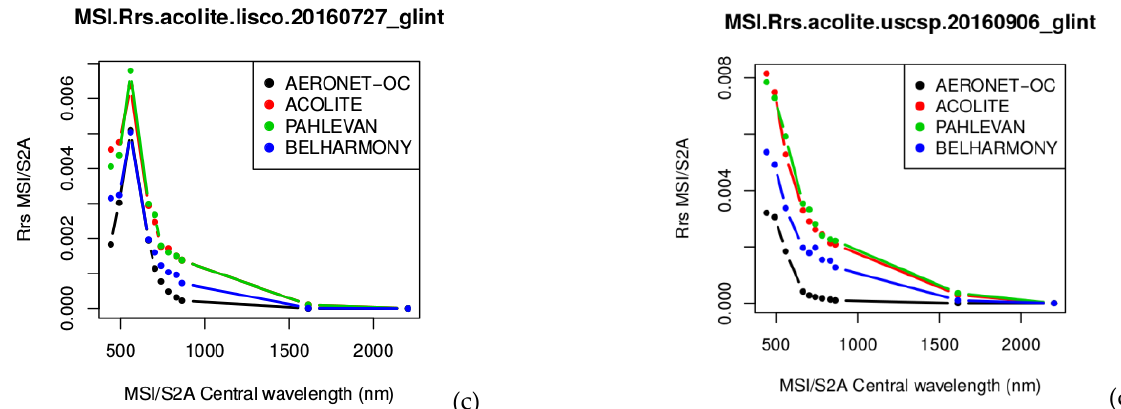
Figure 7. Examples of the output of ACOLITE (Rrs) obtained without gains (red) and with Pahlevan (green) and Belharmony (blue) gains. The AERONET-OC products (black) are also reported. The Rrs are obtained from OLI/L8 (bottom, ( a , b )) and MSI/S2A (below, ( c , d )) images not used for final Belharmony gains calculations.